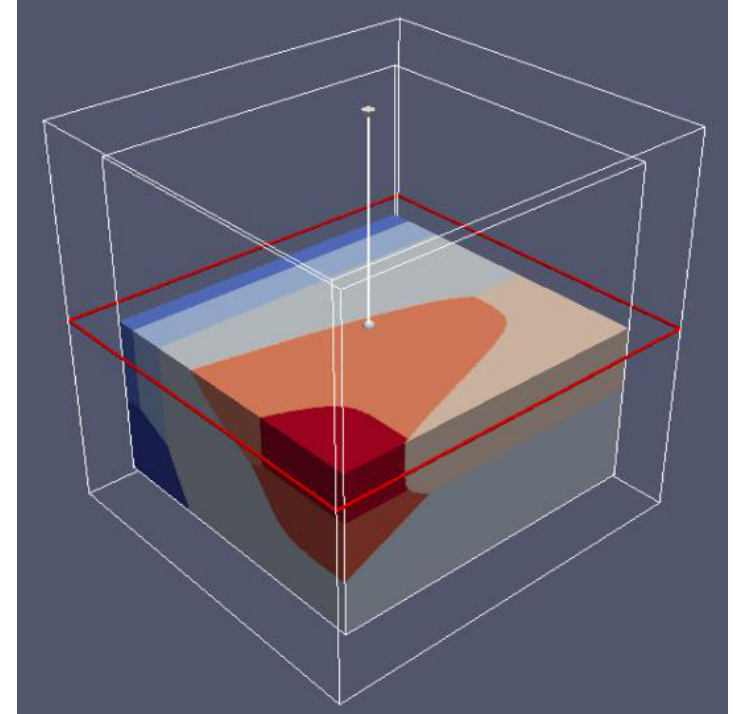
Figure 29. The clip plot shows only regions below the constraint of Eh −0.1 V.